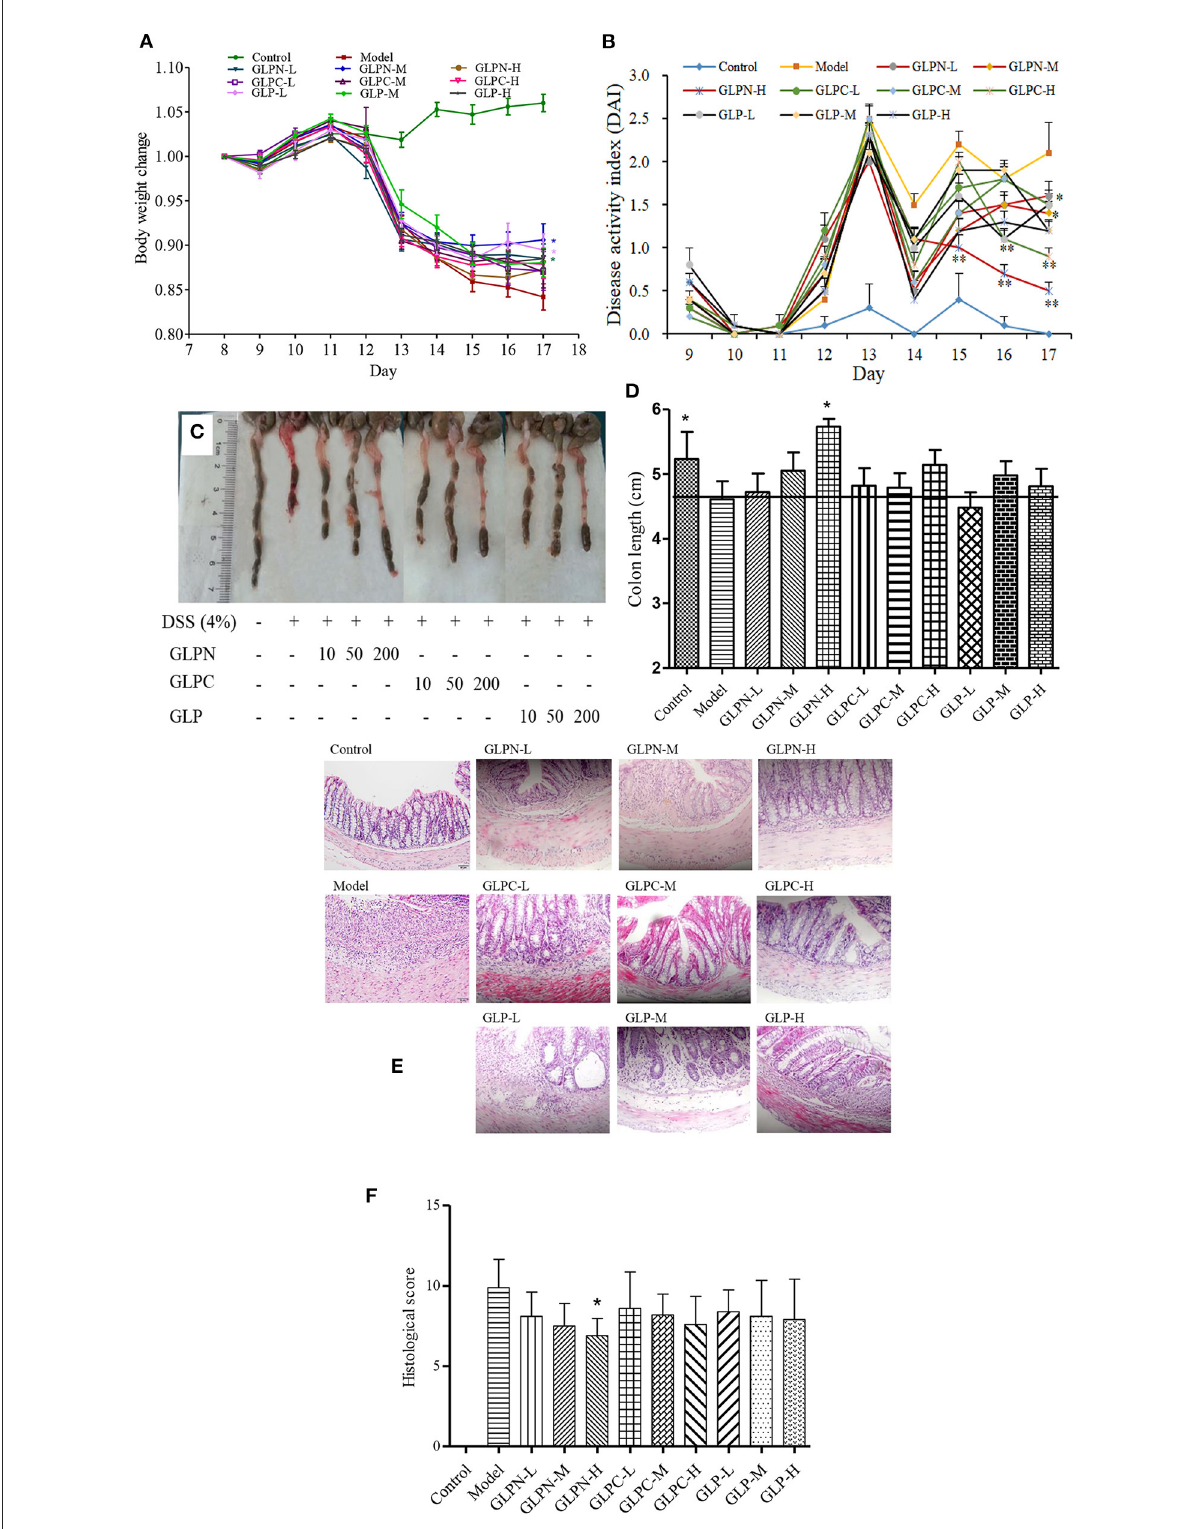
FIGURE6 Effect of GLP and the degraded fractions (GLPC and GLPN) on body weight change, disease activity index, and pathological indicators. (A) Body weight change; (B) Disease activity index; (C) The picture of colons in different groups; (D) The measured length of colons; (E) Representative picture of the colon sections stained with hematoxylin and eosin (H&E); (F) Histological score. Data are expressed as mean ± SD, n = 10 (* P < 0.05, ** P < 0.01 vs. DSS model